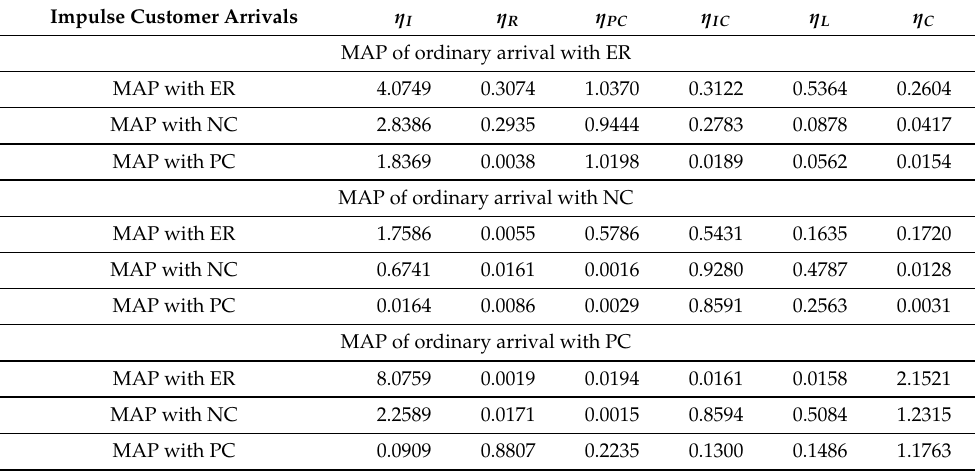
Table 9. Ramification of MAP of ordinary and impulse customer arrivals on various